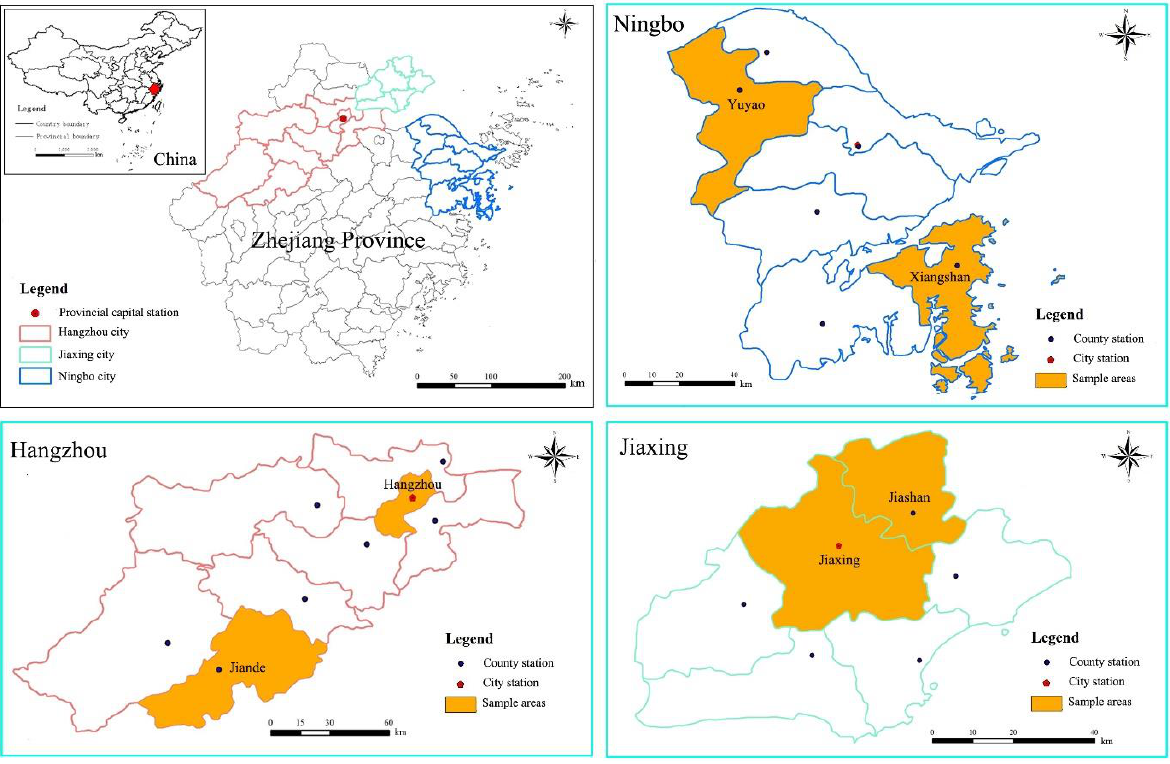
Figure 2. Location of the study area.